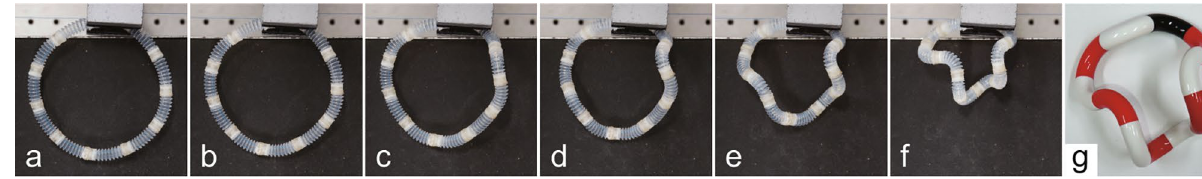
Figure 2. ( a )–( f ) Snapshots of the deformation of a bellows-type structure with n = 10 in the double-traction test (see also Supplementary Movie S3). ( g ) Similar form of a tangle model with n = 11 , where the black body placed at the top is the complement of a space in the